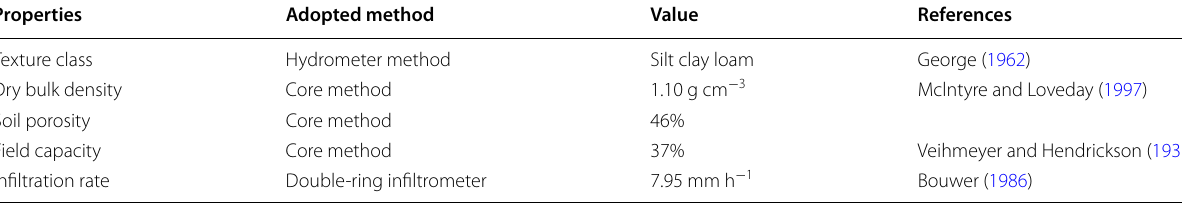
Table 1 Physical and chemical properties analysis of the experimental soil (0–45 cm soil